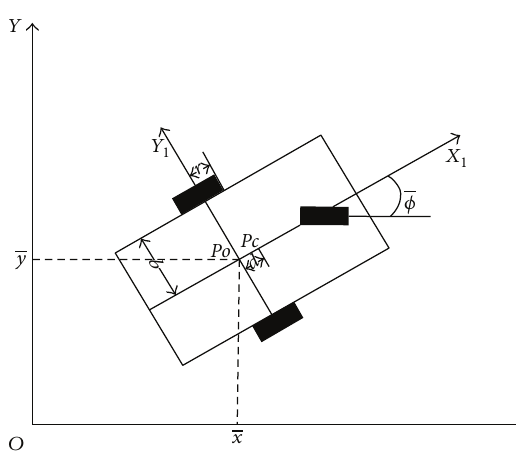
Figure 1: A two-wheeled nonholonomic mobile robot.